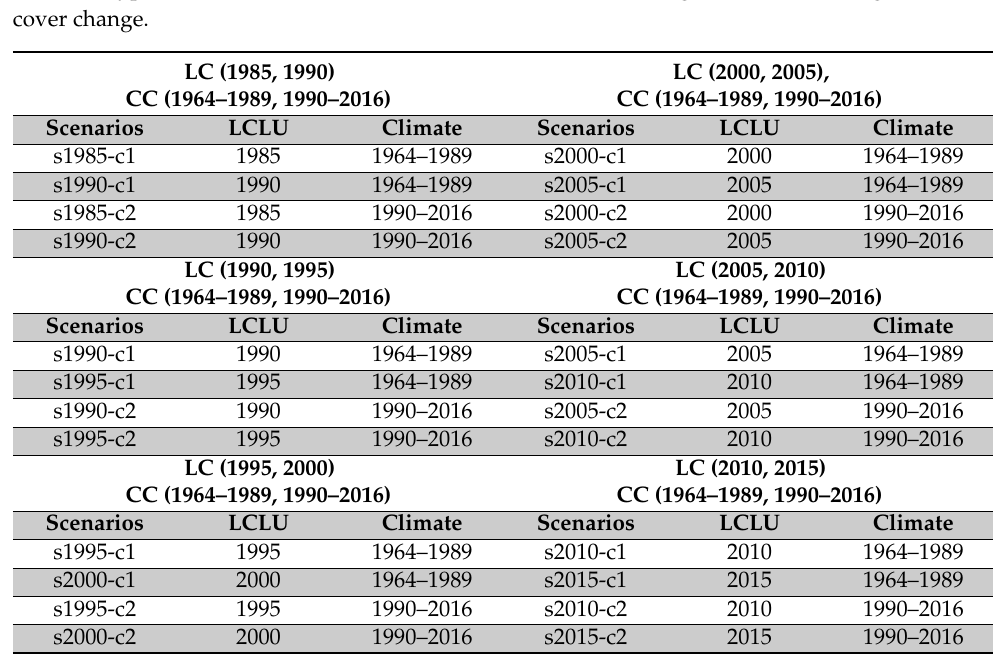
, Q L2 , Q L2 , C2 C1 C1